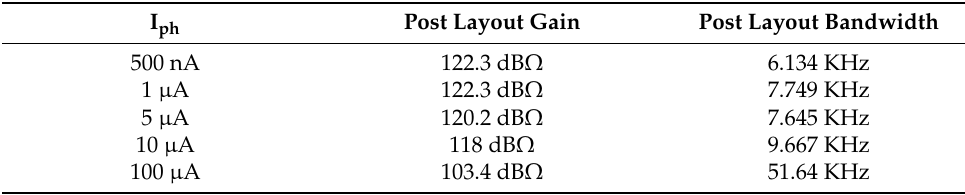
Table 3. Post-layout simulation results for the gain and bandwidth.